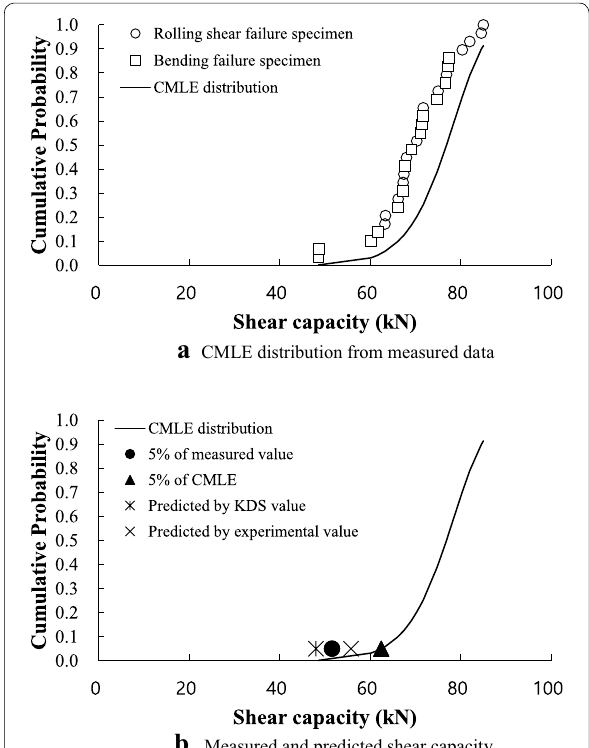
Fig. 9 Comparisons of measured and predicted shear capacity of